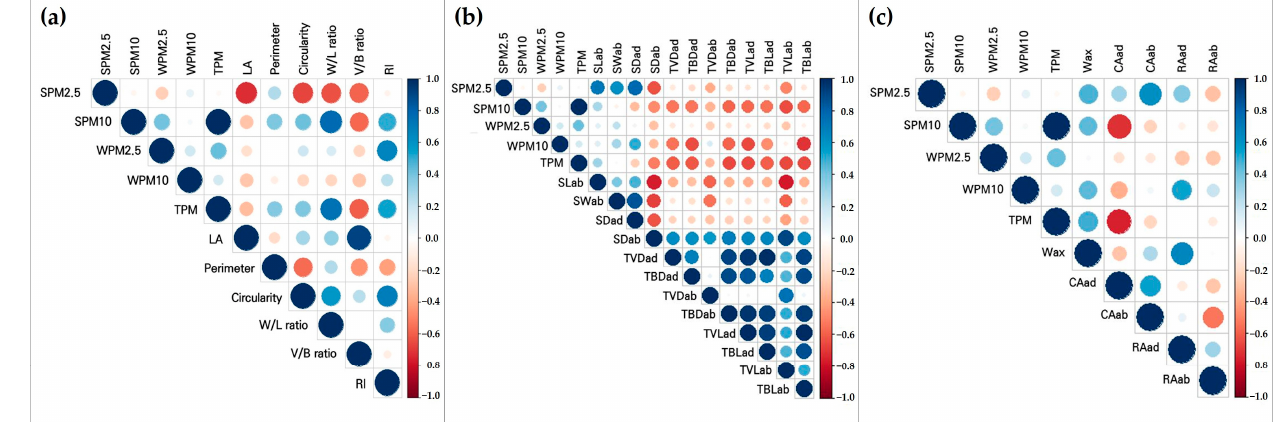
Figure 7. Correlation matrix of leaf structural parameters for ( a ) macro-scale, ( b ) micro-scale, and ( c ) geometric properties in the net PM wash-off ability obtained from the outer crown-positioned leaves during rainfall events in the Seoul Forest Park. Data are mean, n = 10. Note: The color of the spectrum bar represents the correlation between two variables; red signifies a negative correlation and blue denotes a positive correlation. The correlations are proportional to the color saturation and circle size. A small circle displays a weak correlation, while the blue diagonal denotes autocorrelation.